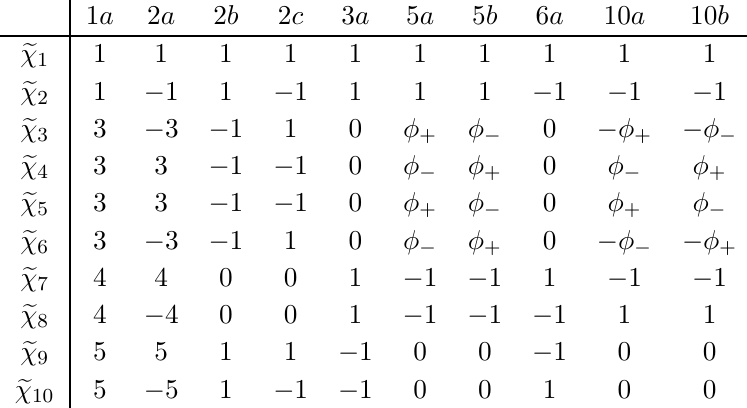
Table 9 . Character table of W ( H 3 ) . We define φ ± = 1